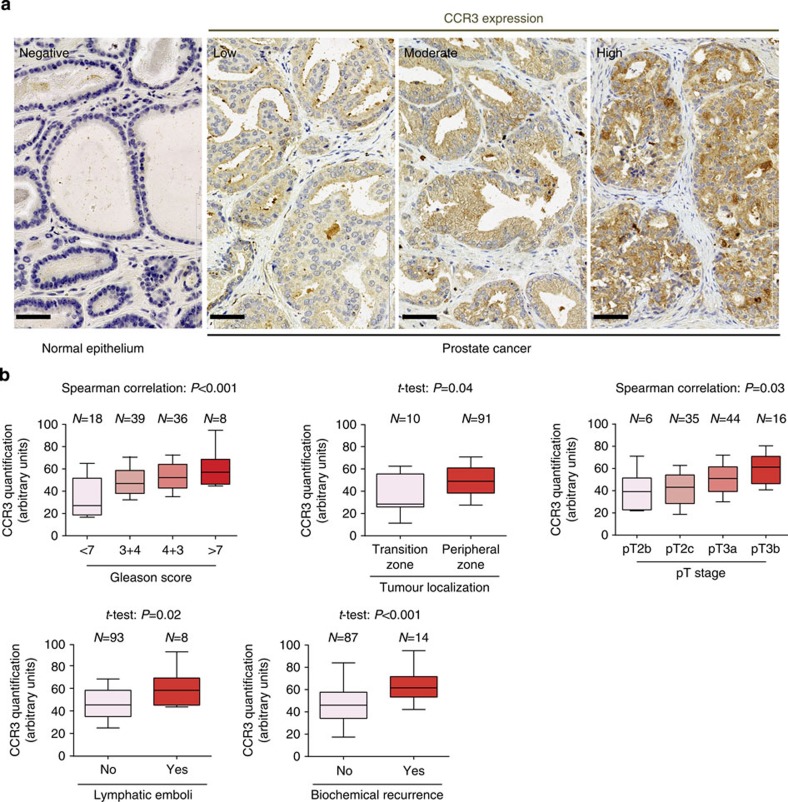
CCR3 is expressed in prostate cancer and its expression is correlated with poor prognosis and a high risk of local extension.(a) Immunohistochemical staining for CCR3, as well as hematoxylin counter-staining, was performed in normal epithelium and human prostate cancer tissues. Two pathologists, who were blind to clinical data, independently scored CCR3 expression. Pictures show a representative experiment for each of the staining intensities of CCR3 expression found in human tumours (low, moderate and high expression) whereas normal epithelium remains negative in all tested samples (pictures, zoom 40 × ). Scale bars, 50 μm. (b) CCR3 expression was evaluated by immunohistochemistry on a TMA containing 101 tumours in duplicate. The boxes represent the median (black middle line) limited by the 25th (Q1) and 75th (Q3) percentiles. The whiskers are the upper and lower adjacent values, which are the most extreme values within Q3+1.5(Q3−Q1) and Q1−1.5(Q3−Q1), respectively. These box plots represent CCR3 values comparing tumours Gleason score, tumour localization, tumour stage, patients with and without lymphatic emboli or biochemical recurrence. For the correlation between CCR3 expression and variables with more than two ordered classes regarding disease severity (for example, Gleason score or tumour stage), we used Spearman's correlation tests assuming a monotonic relation between considered variables. We used Student's t-tests (notified by *) to correlate CCR3 expression to non-ordered categorical variables (for example, presence or not of emboli or biochemical recurrence). The biochemical recurrence, as defined by the European Association of Urology guidelines, corresponded to two PSA readings >0.2 ng ml−1.